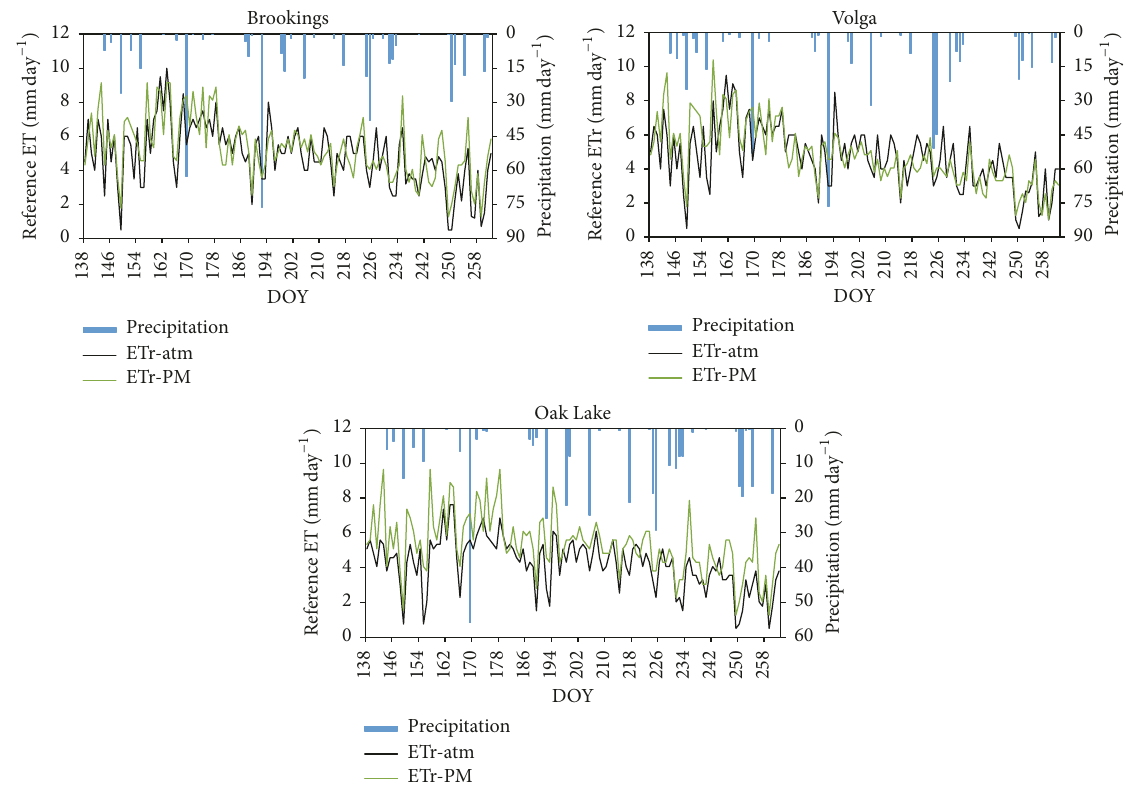
Figure 4: Daily ET and precipitation for three different sites during the 2016 growing season in eastern South Dakota. r